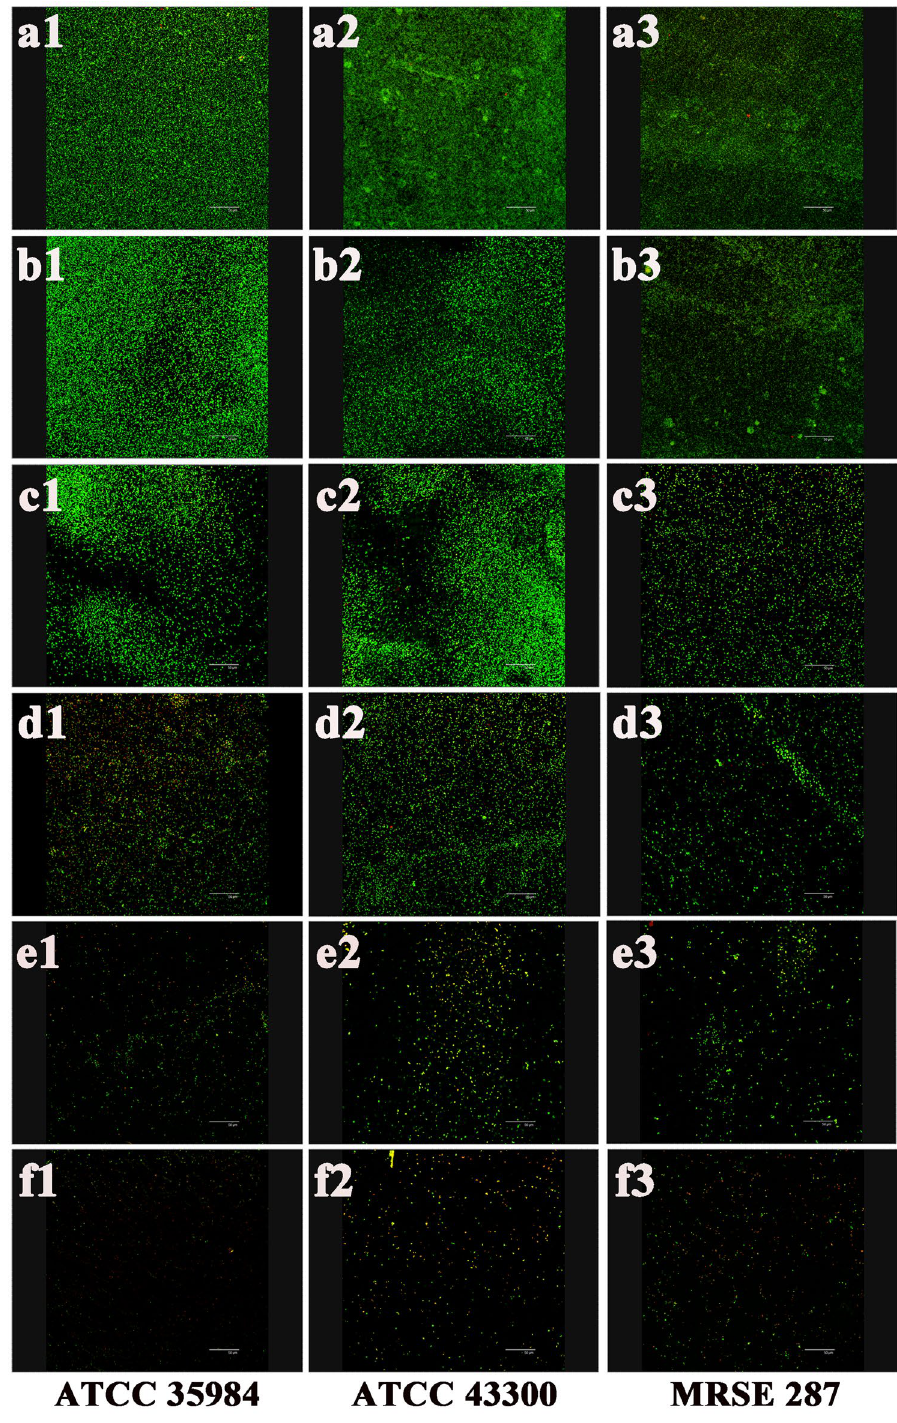
Figure 4. CLSM of biofilm formation on the titanium surface. High-intensity fluorescence was seen in the TSB, 1/8MIC SH, and 1/4 MIC SH groups, and low-intensity fluorescence was seen in the 1/2MIC SH, 1MIC SH, and vancomycin groups. ( a ) Control group. ( b ) 1/8MIC SH group. ( c ) 1/4MIC SH group. ( d ) 1/2MIC SH group. ( e ) 1MIC SH group. ( f ) Vancomycin group. Magnification, ×400. Scale bars, 50